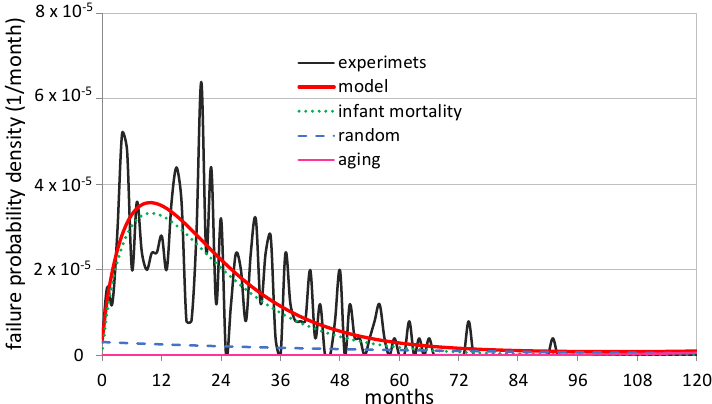
Figure 5. Failure probability density function of microcontrollers: experimental data, model and single components of the model.